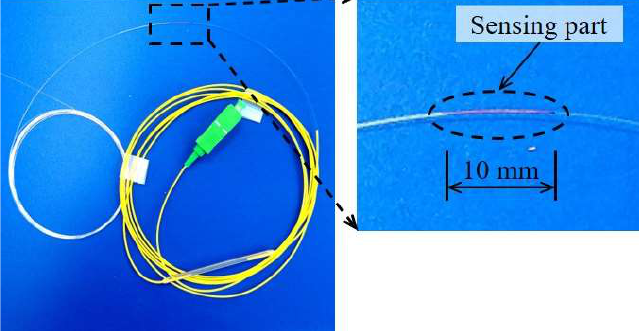
Figure 3. A picture of the FBG-optical fiber sensor.